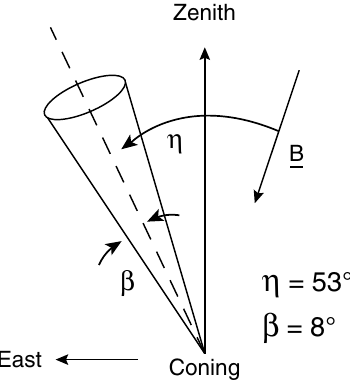
Fig. 3. Coning angle of the rocket with respect to the magnetic field.